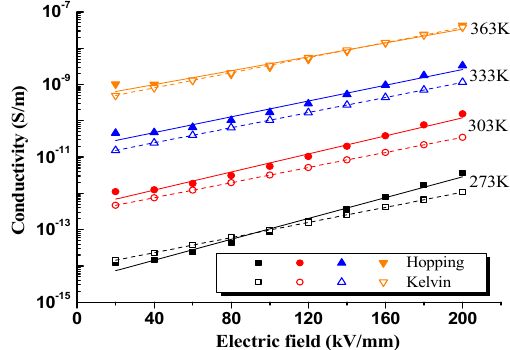
Figure 9. Comparison of calculated hopping and Kelvin conductivity under different temperatures and electric fields.